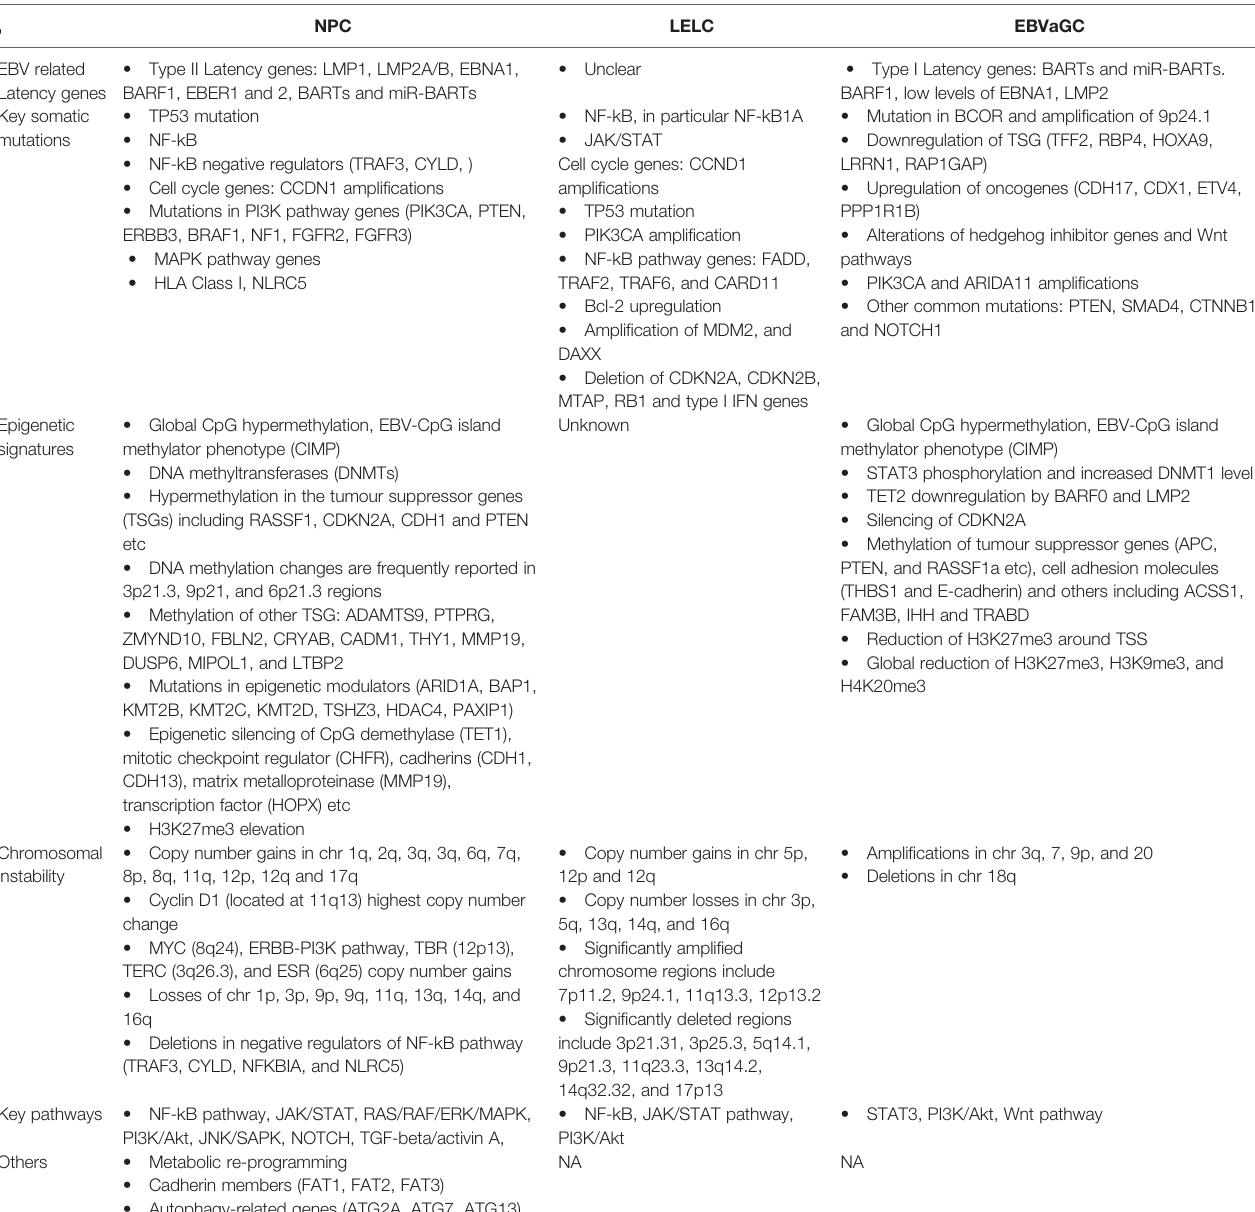
TABLE 2 | Genomic and epigenomic differences between nasopharyngeal carcinomas (NPCs), lymphoepithelioma-like carcinomas (LELCs) and EBV-associated gastric carcinomas (EBVaGCs). , NPC LELC